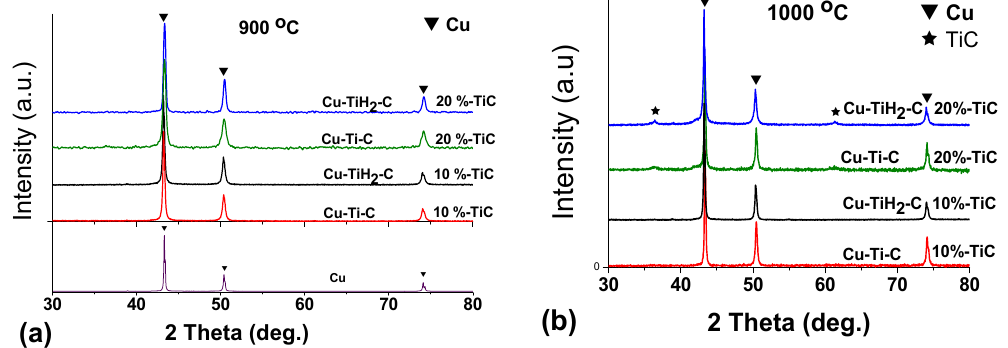
Figure 3. XRD patterns of nanocomposites ( a ) Spark Plasma Sintered at 900 °C; ( b ) Spark Plasma Sintered at 1000 °C. Table 2. Fraction of phases of Cu–TiH2–C and Cu–Ti–C composites sintered at 1000 °C calculated by Rietveld refinement.